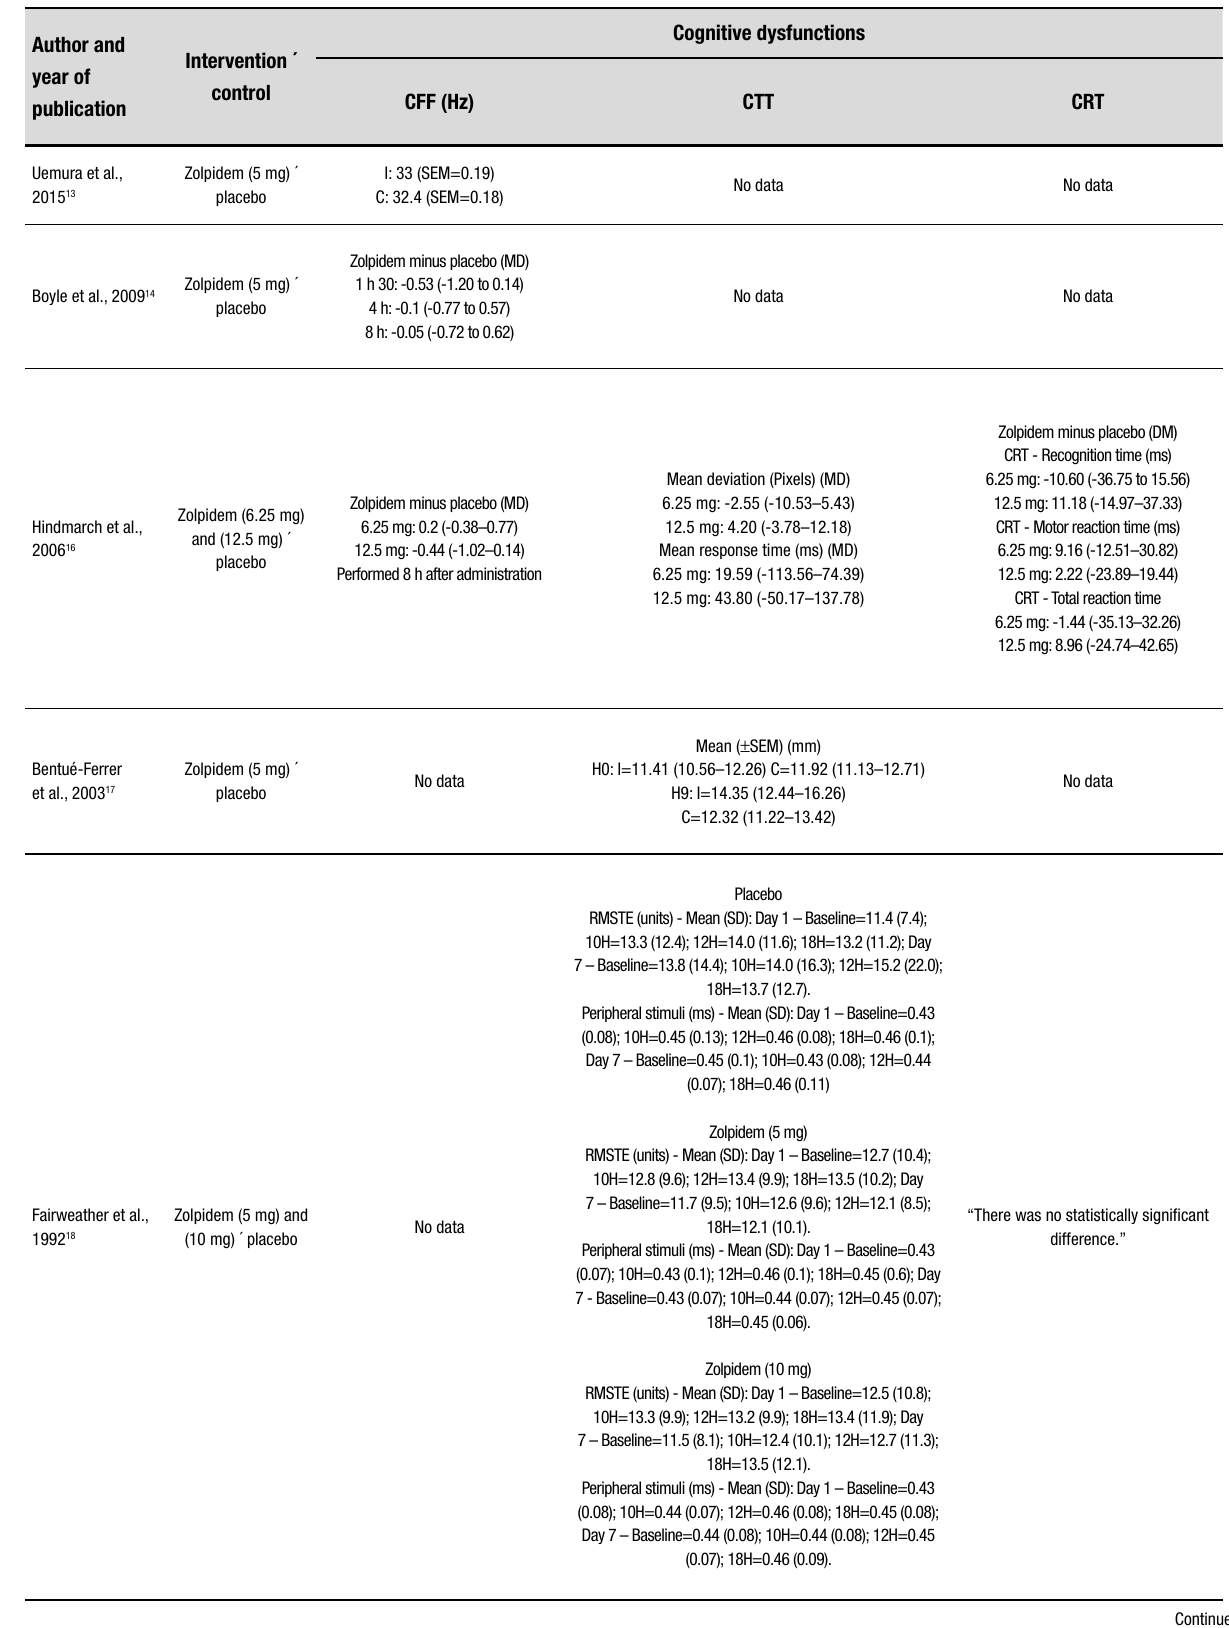
Table 3. Results: cognitive